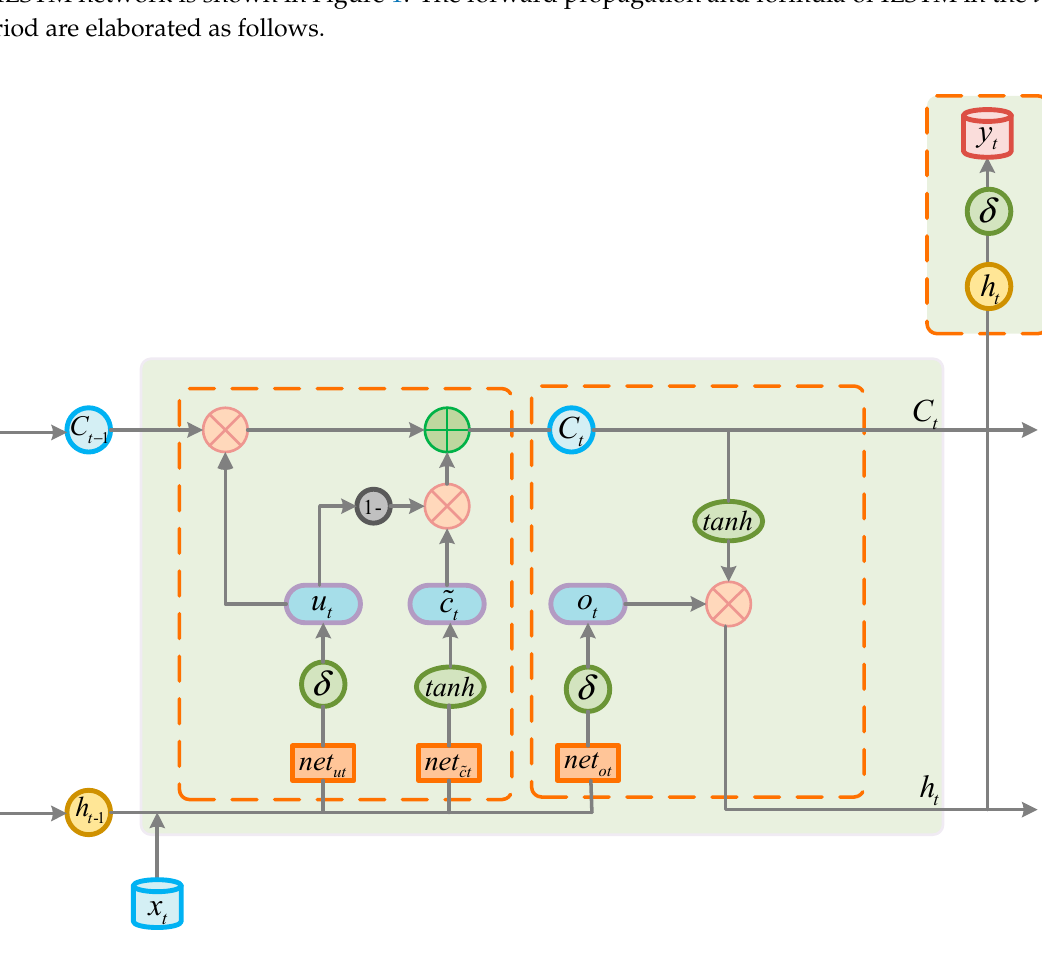
Figure 1. Schematic diagram of the Improved Long Short-Term Memory (ILSTM) network structure. Calculate shared